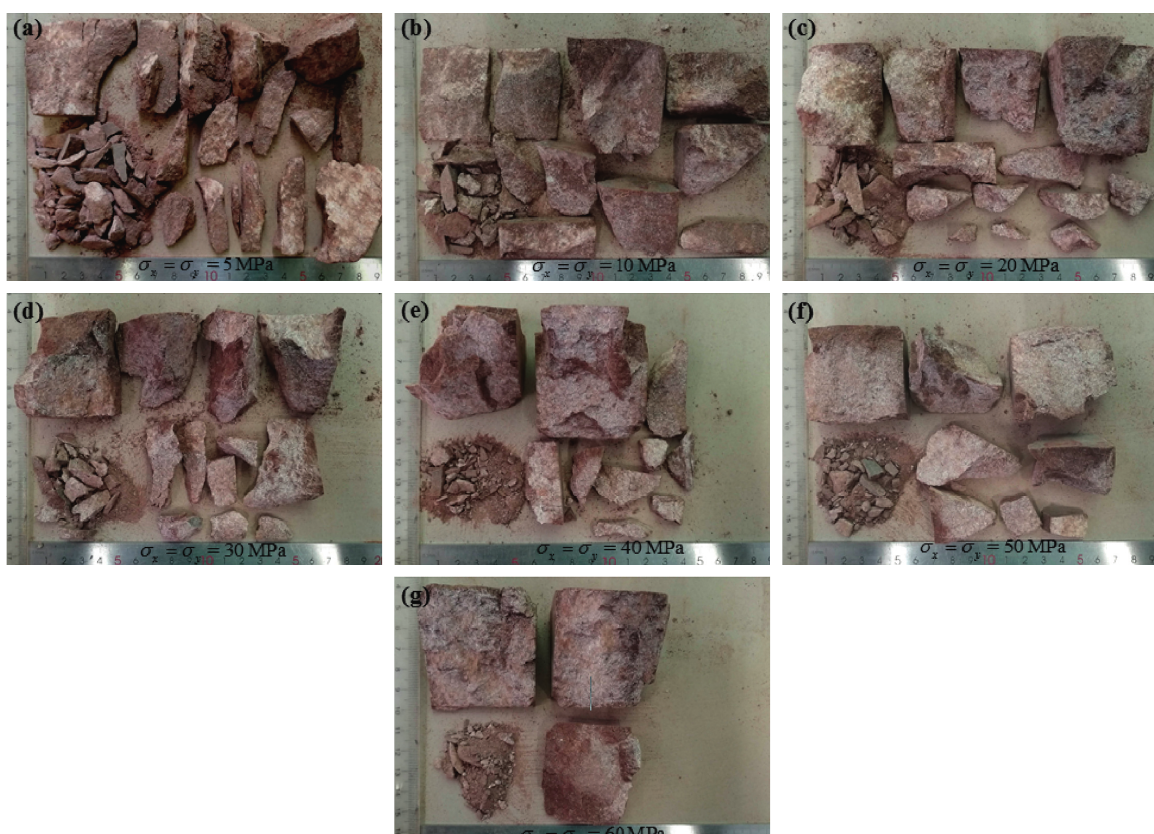
Figure 8: Failure characteristics of TCT at different confining